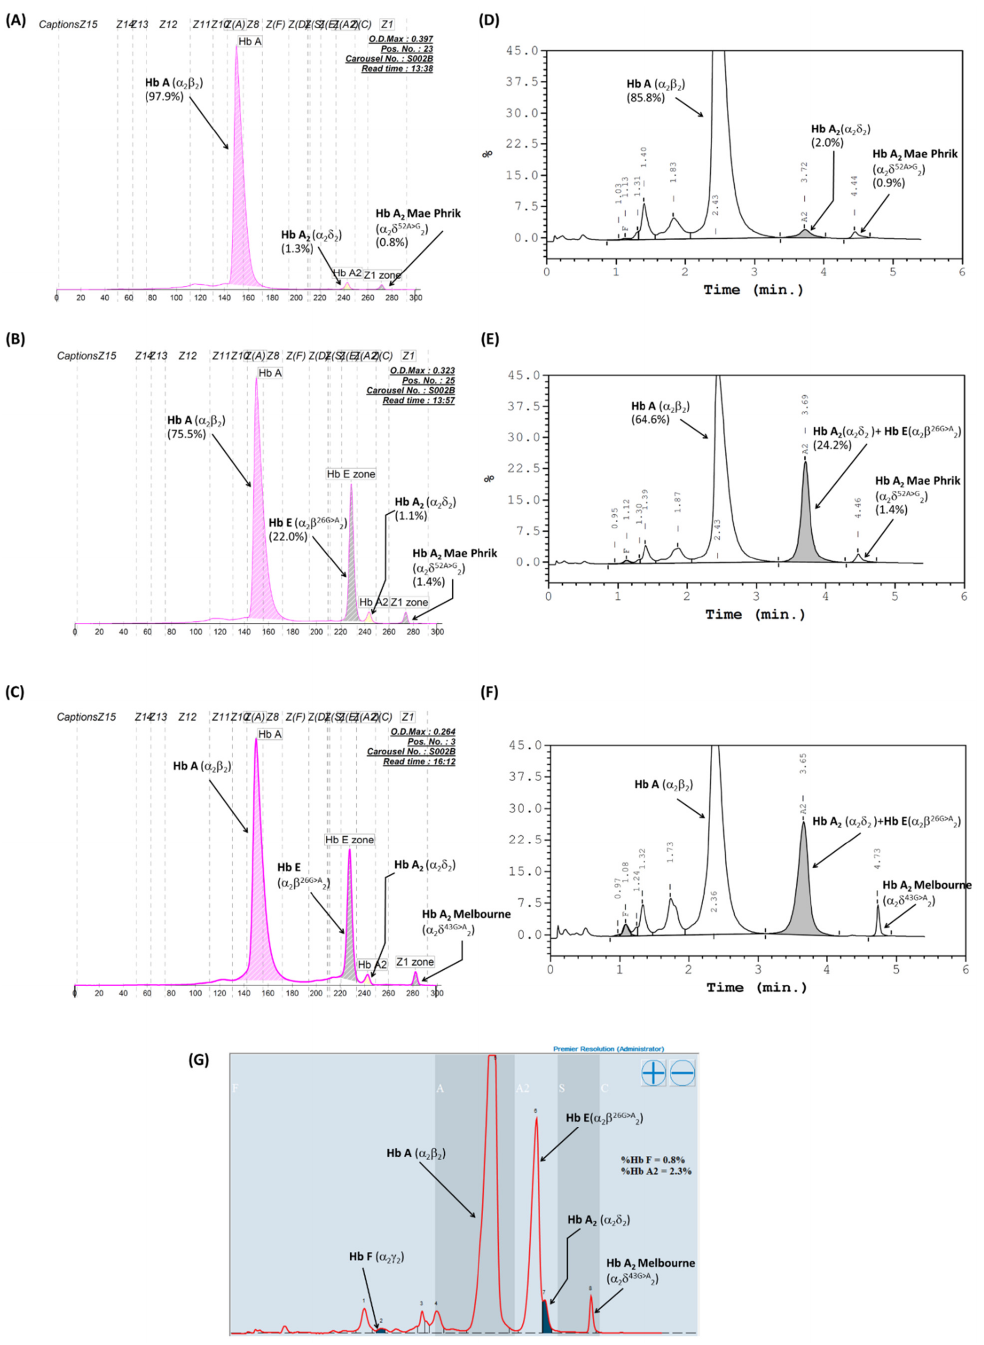
Figure 2. Representative Hb separation profiles of Hb A 2 -Mae Phrik using an automated Hb analyzer. ( A , D ): Electrophoretic and chromatographic mobility pattern of heterozygous Hb A 2 -Mae Phrik, observed in mother of subject 1. Hb A 2 -Mae Phrik migrates into the first position of the migration zone ( A ) and was eluted from the column after Hb A 2 at a retention time of 4.44 min ( D ). ( B , E ): The Hb pattern of compound heterozygous Hb A 2 -Mae Phrik and Hb E observed in subject 1. Hb E and Hb A 2 were completely separated, and a small peak of Hb A 2 -Mae Phrik also migrates to zone 1 on the electropherogram ( B ), while the HPLC chromatogram shows that Hb E and Hb A 2 were eluted at the same retention time and Hb A 2 -Mae Phrik was completely separated from these, being eluted at a retention time of 4.46 min. ( C , F , G ): Electrophoretic ( C ) and chromatographic ( F , G ) mobility pattern of coinherited Hb A 2 -Melbourne with Hb E. The separated profiles of Hb A, Hb E, Hb A 2 , and A 2 -Melbourne are